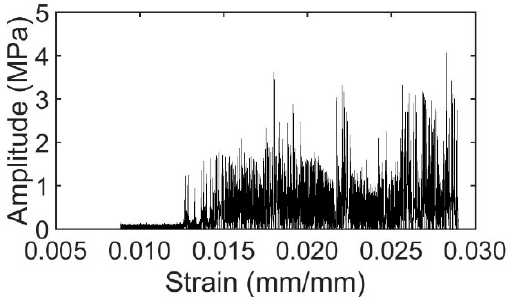
Figure 10. Absolute values of the resulting signal resulting from subtracting the original and filtered curve.